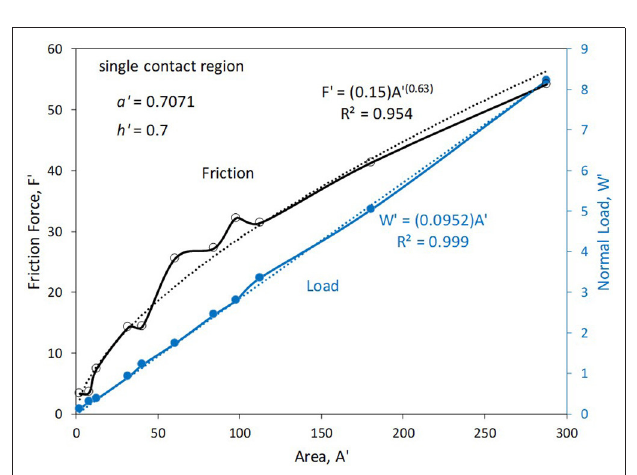
FIGURE 6 | Friction force vs. total contact area for slider arrays. Each curve corresponds to a given individual slider area. Graphic shows the slider array configuration when 9 sliders are used.